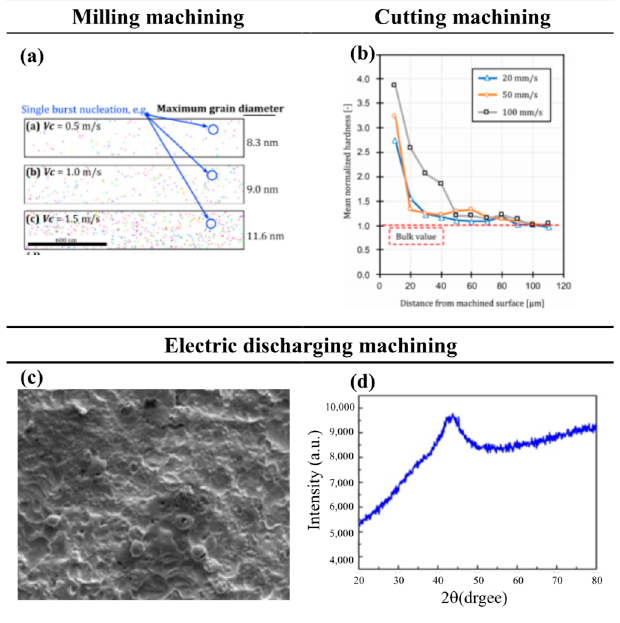
Figure 13. ( a ) The number of nanocrystals increases as the milling speed increases, adapted with permission from Ref. [102]. 2020, Elsevier. ( b ) Changes in microhardness from the machined surface to the inside of the workpiece after two − dimensional cutting of Fe − Si − B by Fang et al., adapted with permission from Ref. [79]. 2021, Elsevier. ( c ) The surface after EDM of the Fe − based BMG. ( d ) The XDR pattern of the Fe − based BMG after EDM [103]. Although there are many pits on